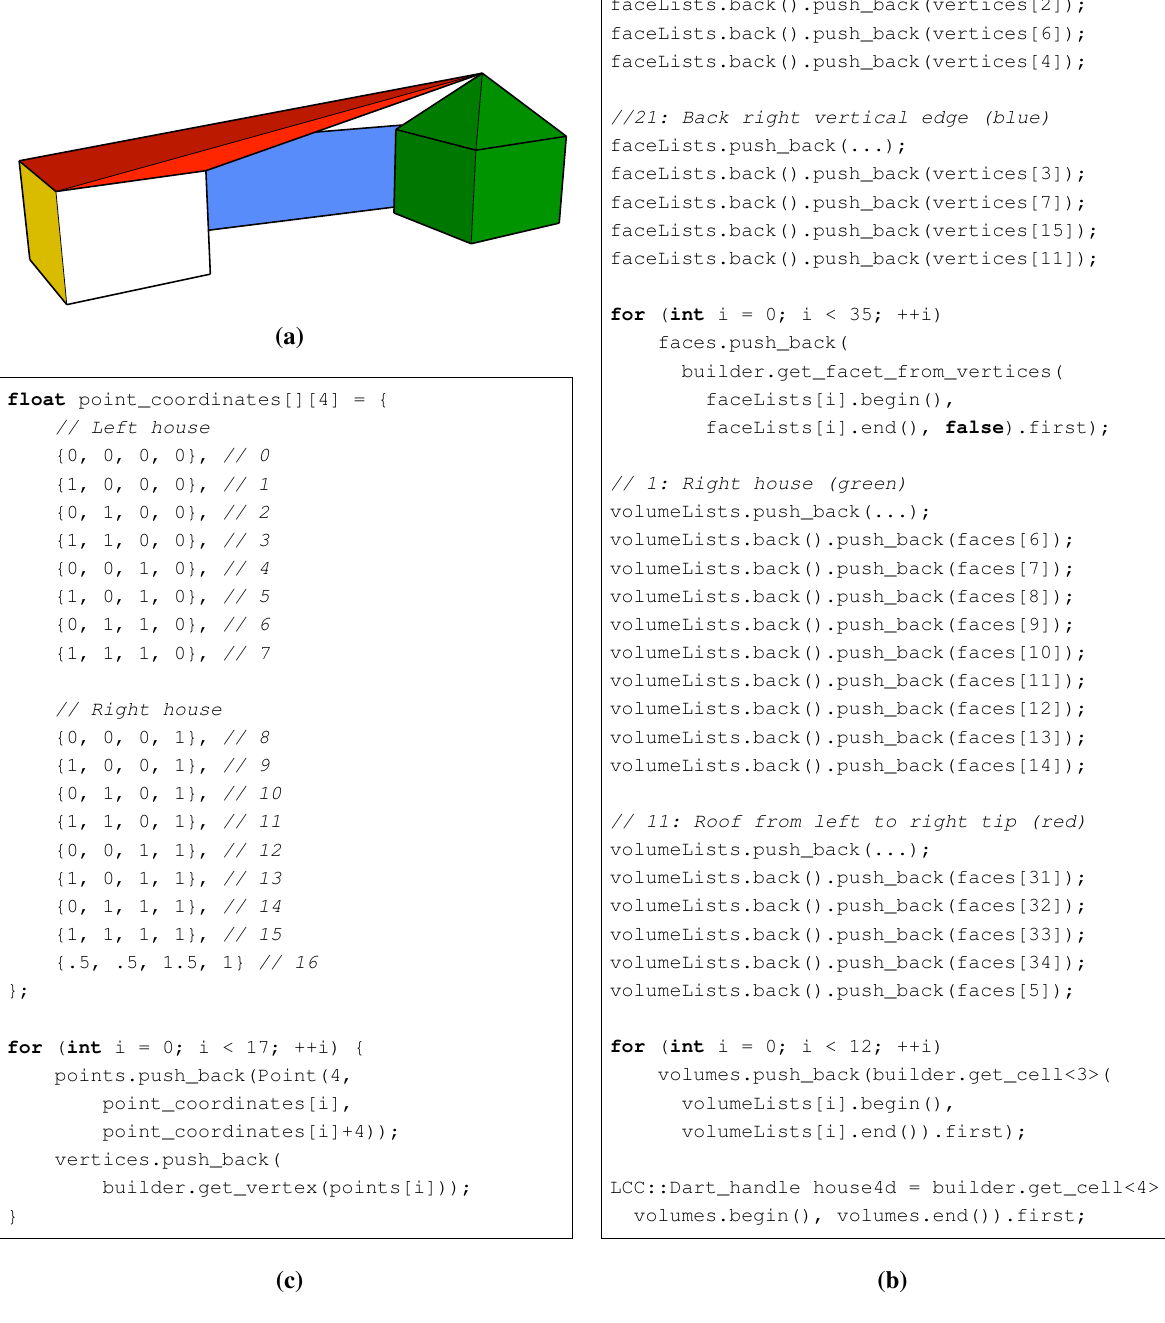
(b) correspond to the highlighted faces and volumes in